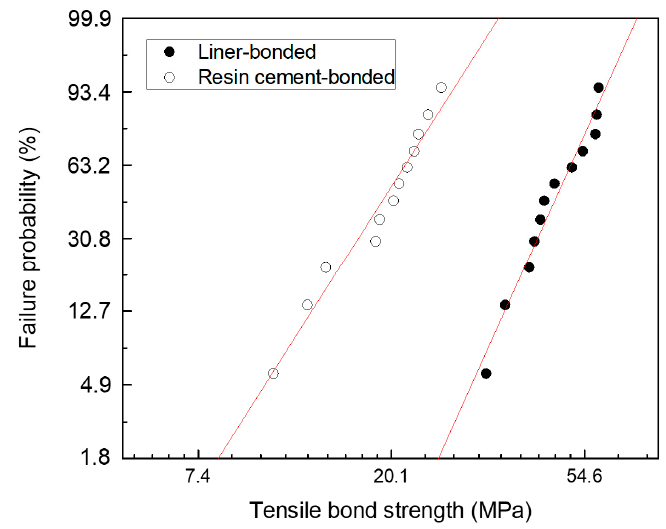
Figure 2. Weibull plots of a microtensile bond strength test for lithium disilicate-reinforced glass ceramic and zirconia of the liner-bonded group and the cement-bonded group. The heat-bonding with the liner was found to induce a chemical interaction with the milled zirconia ceramic abutment. A large number of pores was found in the reaction layer of liner bonding, altering the surface topography of the zirconia ceramic (Figure 3a,b). The zone of the chemical reaction was measured approximately 3 µm across the interface of the bonding of the zirconia ceramic (Figure 3d,e).